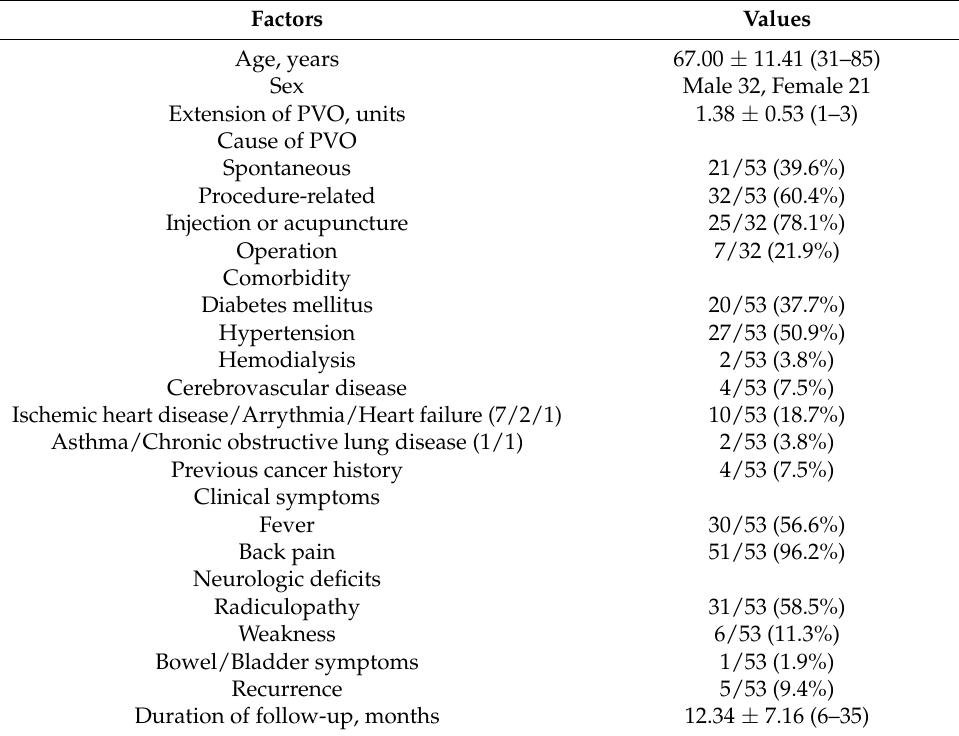
Table 1. Demographic and clinical data of 53